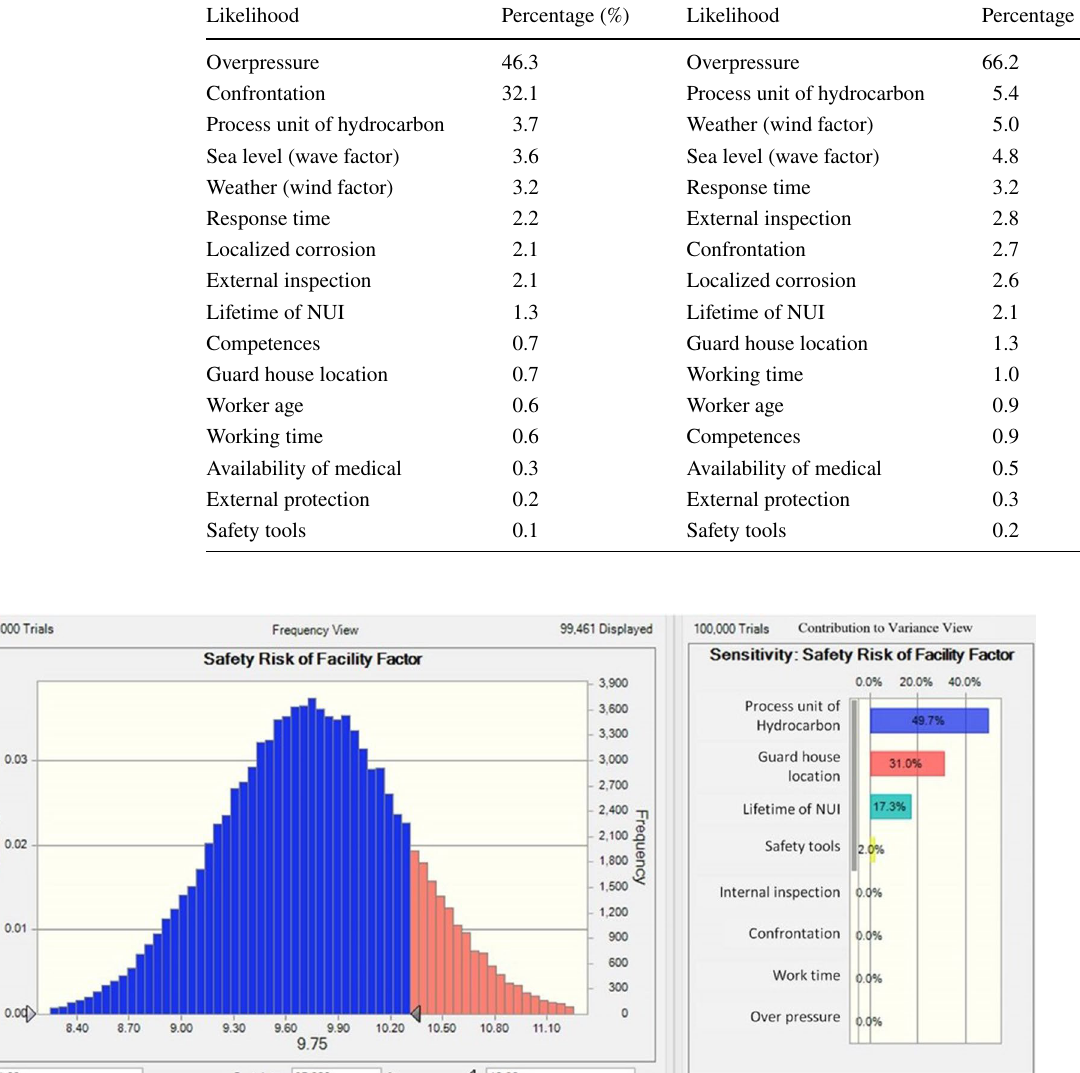
Table 9 Percentage of likelihood factor